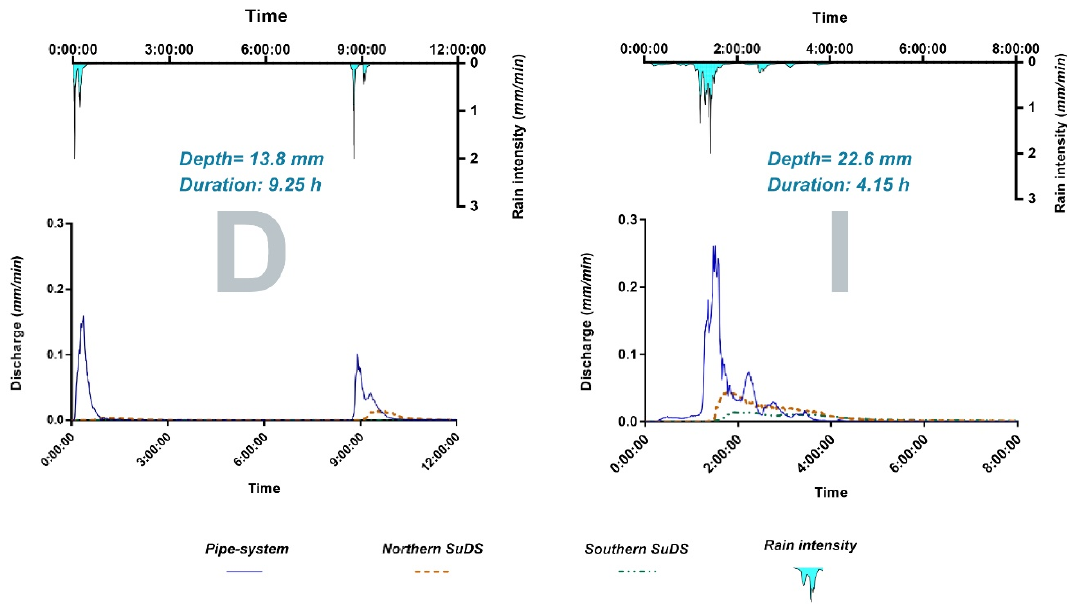
Figure 4. Two examples from the monitored hyetographs and hydrographs during this study. See rainfalls D and I in Table 2. The details of all rainfall-runoff observations are provided as supplementary material (available